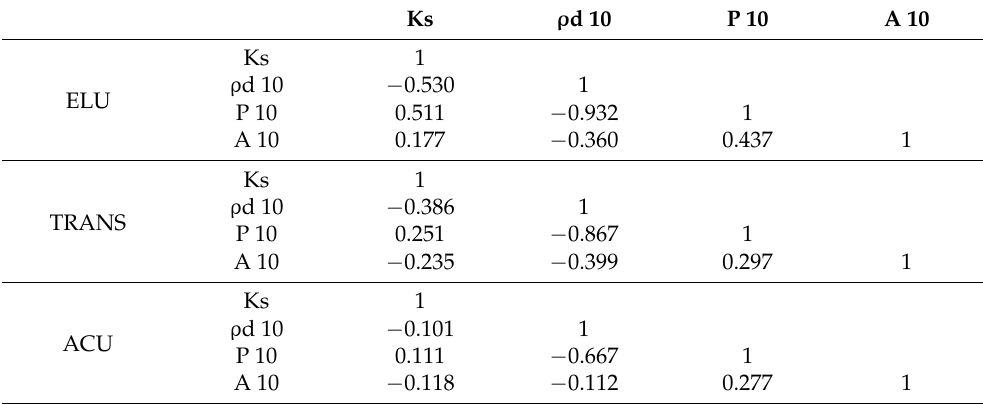
Table 2. Correlation analysis of all monitored parameters for hydro-physical properties at 10 cm of the soil profile.